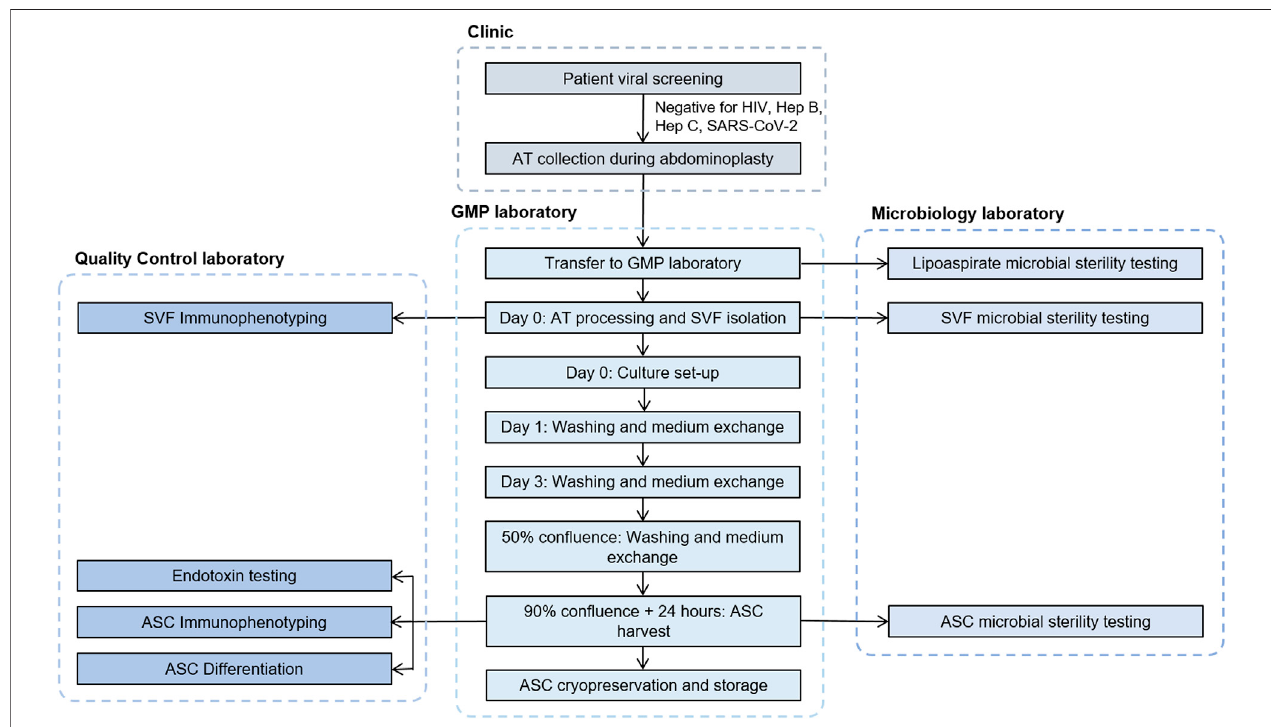
FIGURE 2 | Flowchart describing the process steps and testing involved from donor quali fi cation to cryopreservation of ASCs. ASC, adipose-derived mesenchymal stromal cells; AT, adipose tissue; GMP, good manufacturing practices; SVF, stromal vascular fraction.